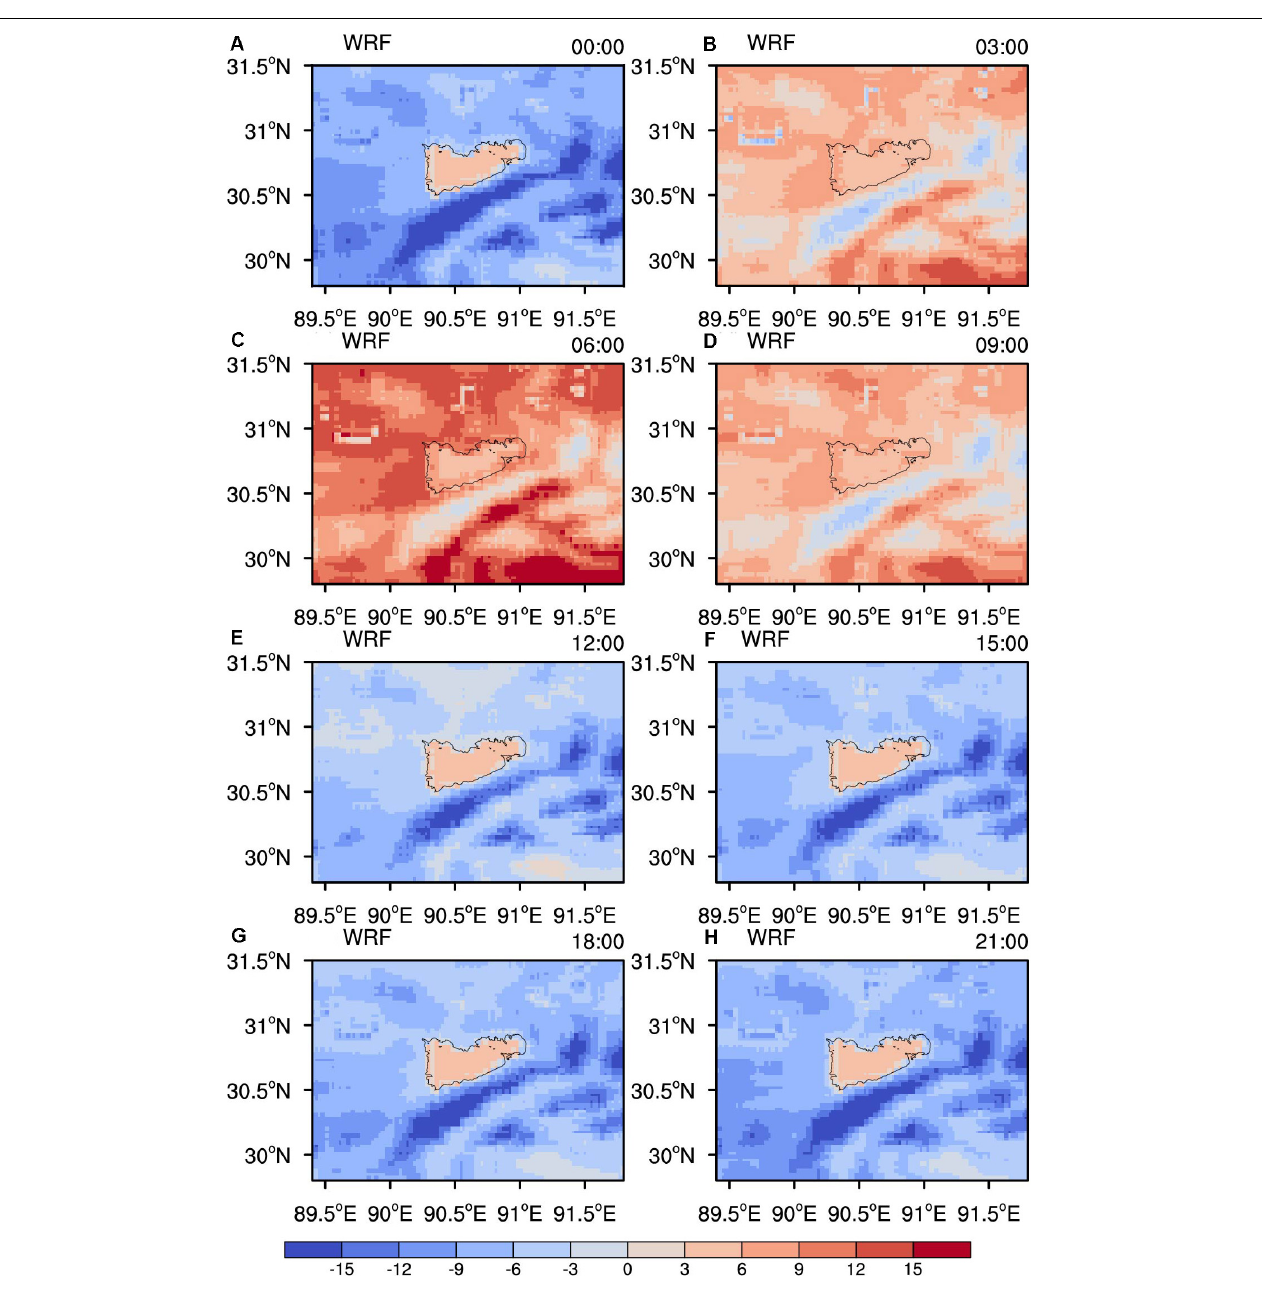
FIGURE 8 | Same as Figure 7 , but for October